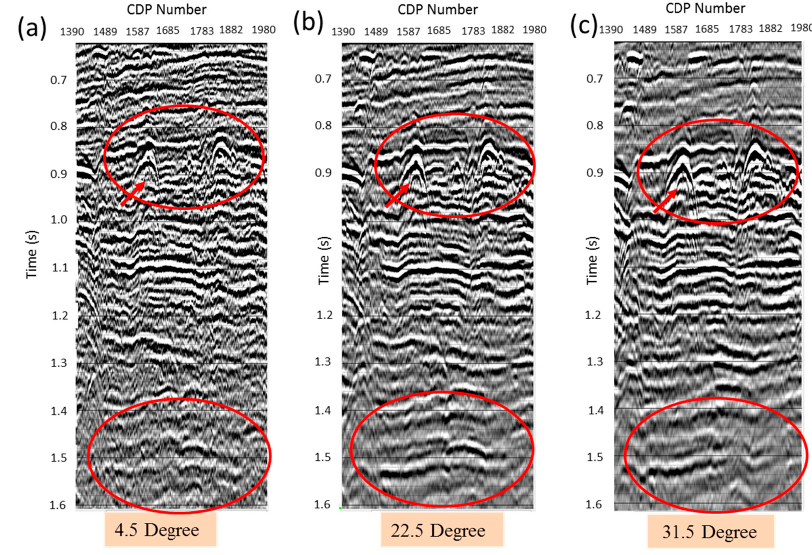
Figure 8. Angle stack seismic data at three different angles ( a ) Range limited stack data with 4.5 degrees, ( b ) 22.5 degrees, and ( c ) 31.5 degrees. Geosciences 2018 , 8 , 74